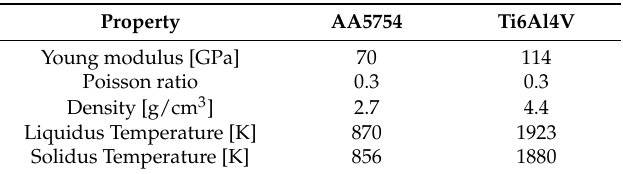
Table 2. Mechanical and thermo-physical properties of the two alloys.